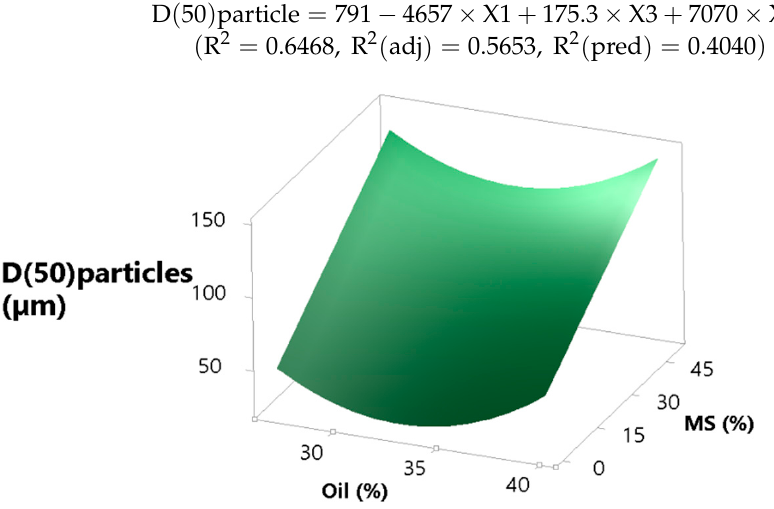
Figure 6. MS and oil concentration effect on the size of spray dried particles, expressed as d(50). With SEM pictures of selected samples, the morphology of the particles was